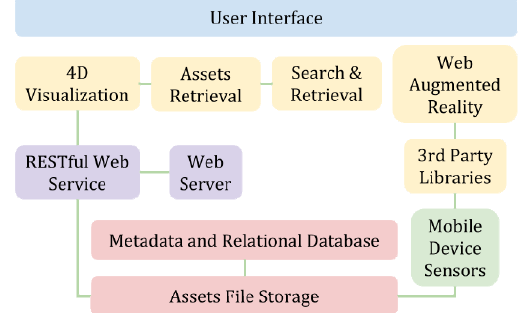
Figure 1. Browser/server architecture of the METEORA platform; each color represents a different layer: yellow for the presentation layer, purple for the application layer, red for the persistence layer and green for the Inertial Measurement Unit (IMU) of the mobile